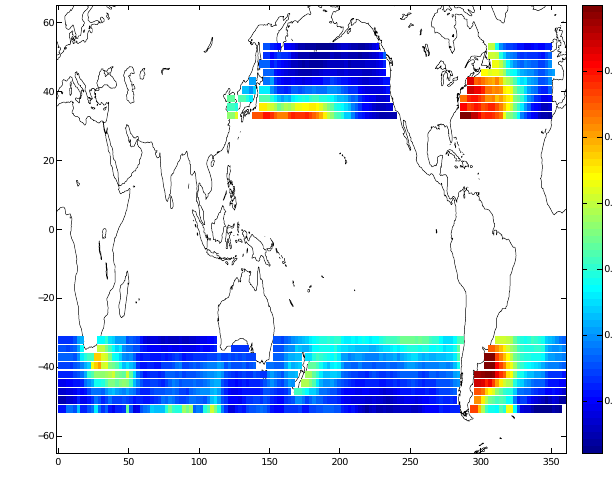
Fig. 11. JJA mean climatological spatial distribution of the fre- quency of Cluster 4 (Deep Altostratus).